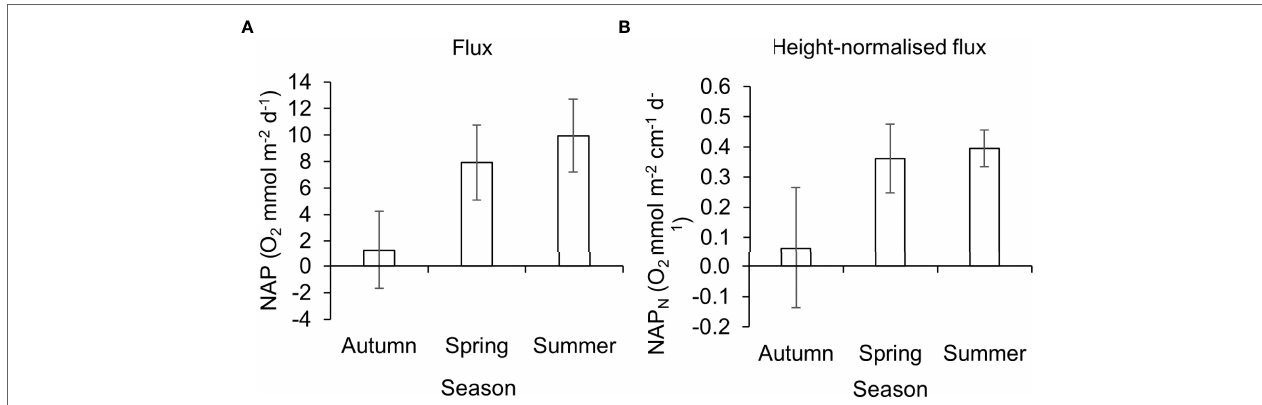
FIGURE 4 | (A) Net Apparent Productivity (NAP) and (B) NAP canopy-height-normalised flux (NAP N ) of P. oceanica meadow edge determined across seasons with large benthic chambers. Autumn and spring n = 3, summer n = 4. Error bars represent standard